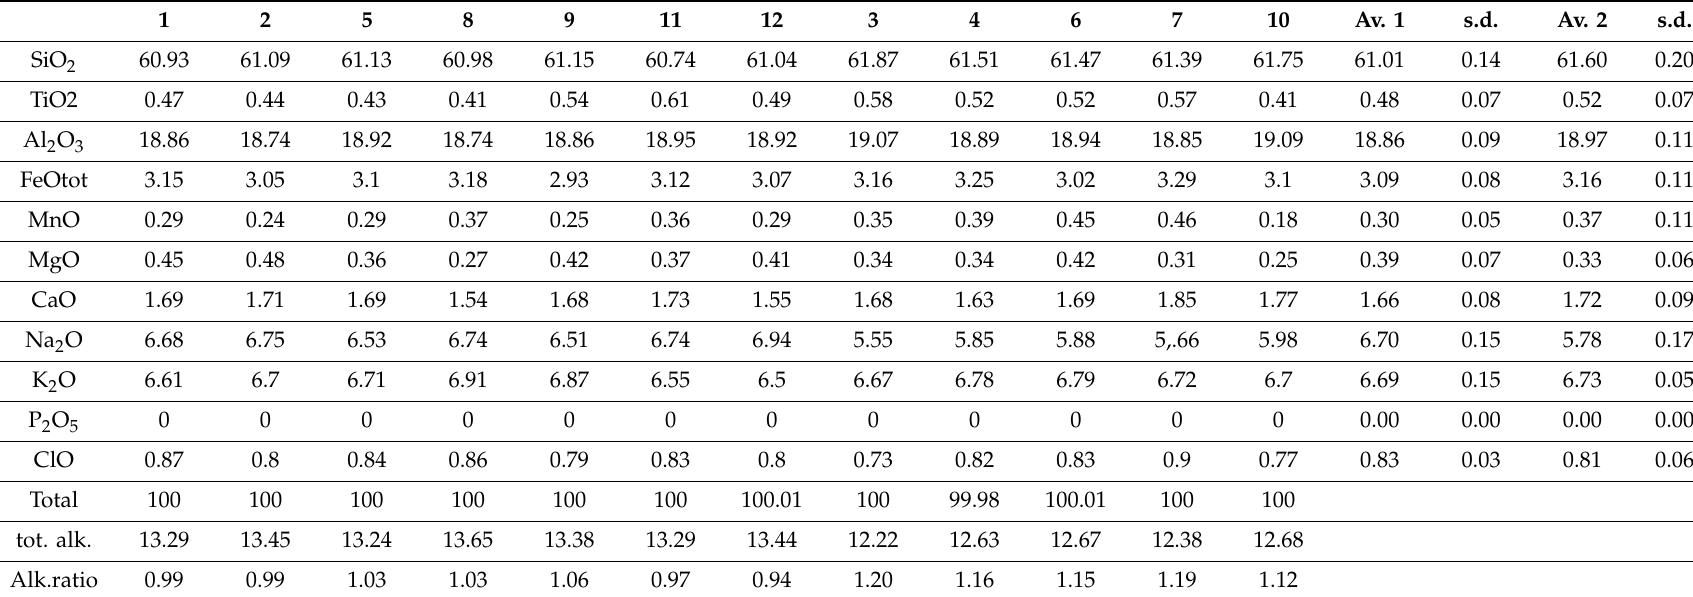
Table 2. EDS chemical analysis of the tephra samples TU1. s.d.: Standard